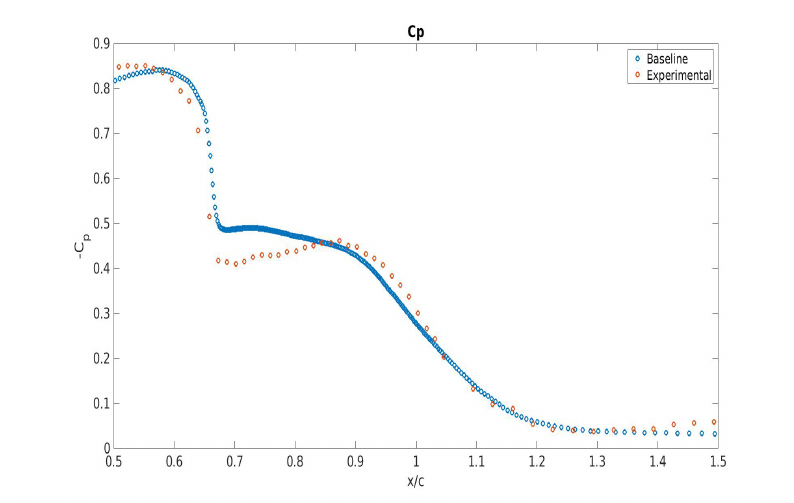
Figure 10. Skin friction coefficient.